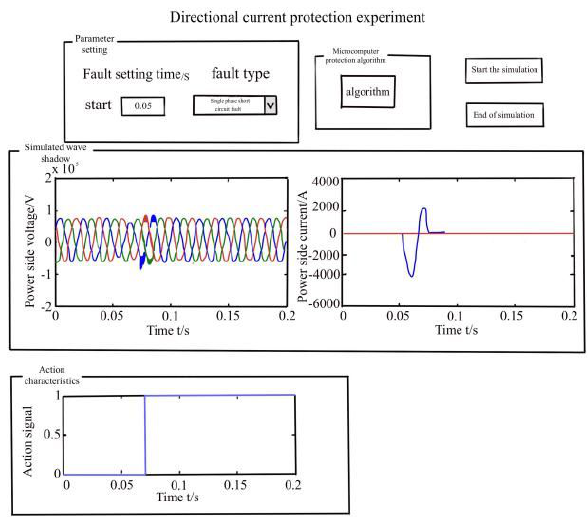
Figure 13: Voltage, current and action signals of power supply